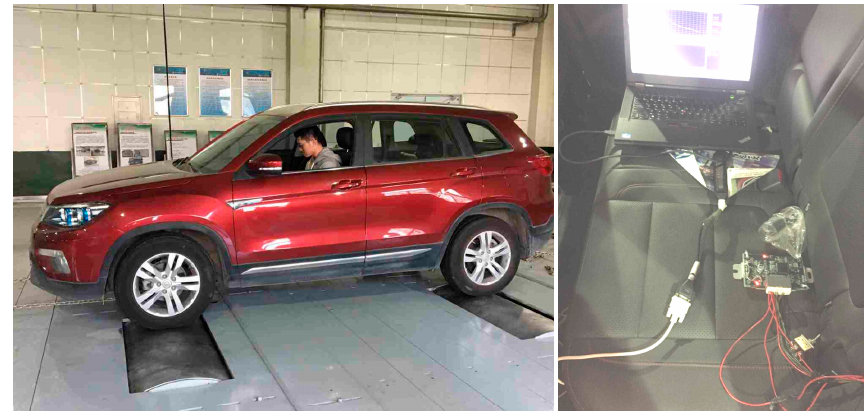
Figure 14. Revolving drum test.